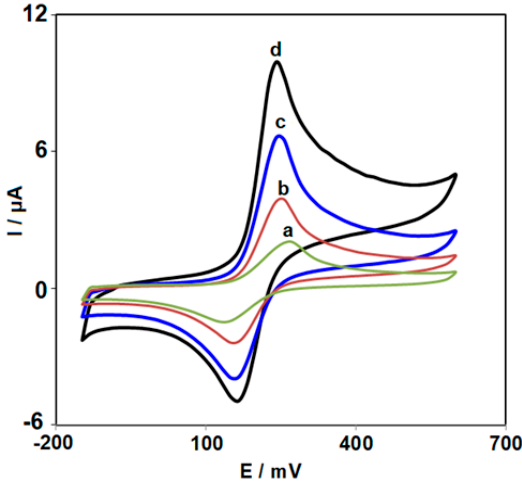
Figure 5. Cyclic voltammograms captured for oxidation of KTC (70.0 μ M) in PBS (0.1 M; pH = 7.0) on: ( a ) unmodified CPE; ( b ) Ce-BTC MOF/CPE; ( c ) IL/CPE; and ( d ) Ce-BTC MOF/IL/CPE, with a scan rate of 50 mV/s.